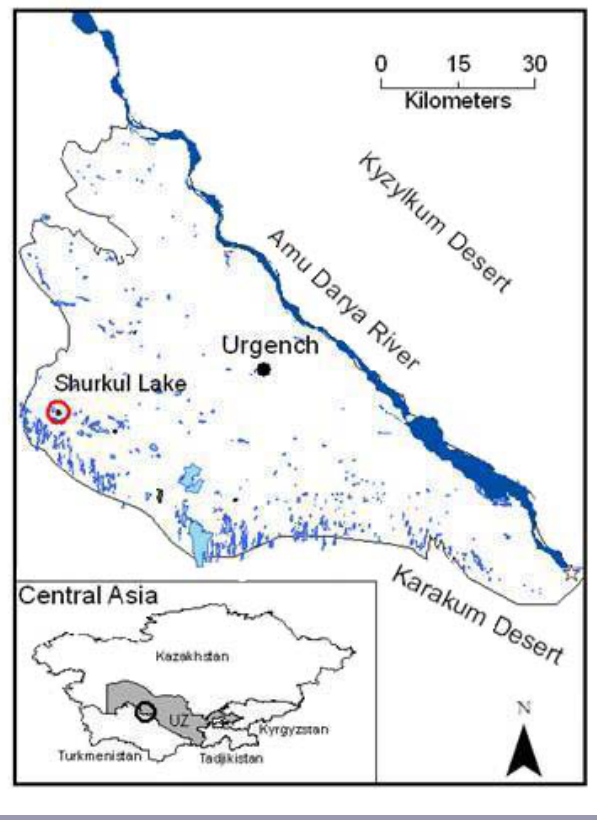
Fig. 1 . Map of the study area showing the location of Shurkul in the Khorezm province (source: GIS-lab of the ZEF-UNESCO